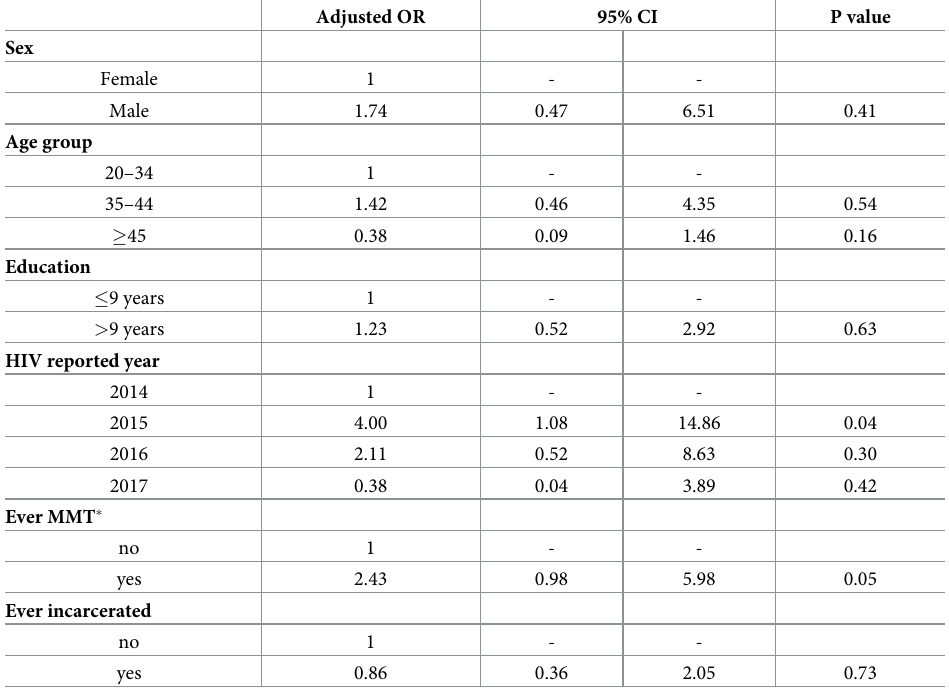
Table 3. Factors associated with propofol injection from multiple logistic regression (N =